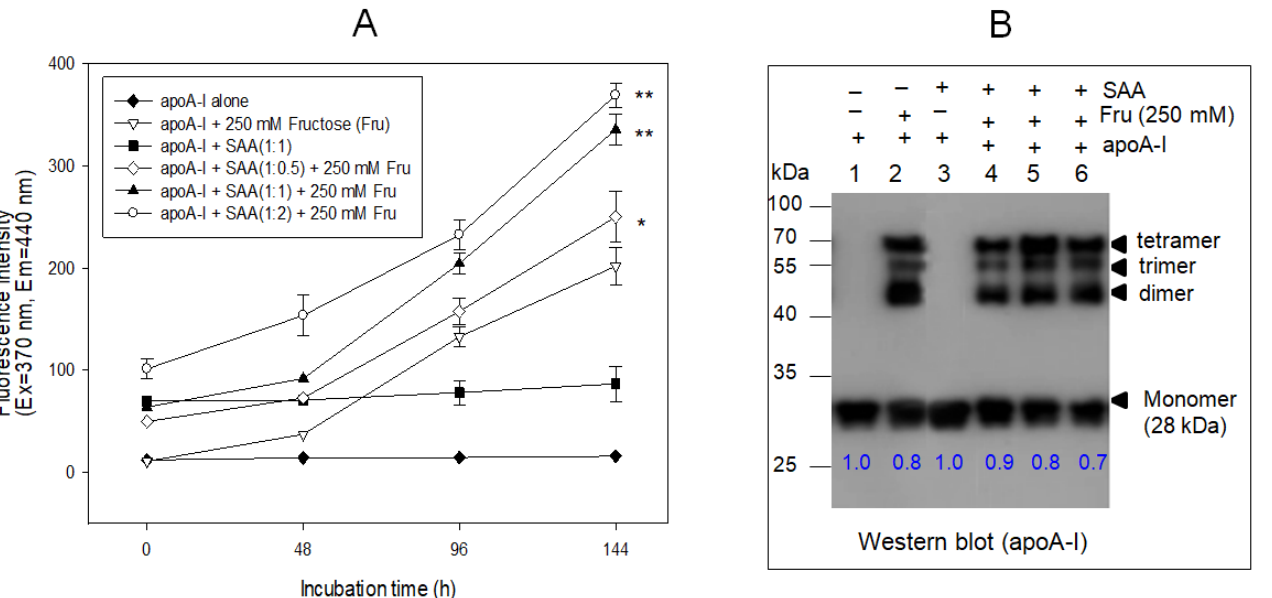
Figure 5. Isothermal denaturation of apoA-I and serum amyloid A (SAA) in the lipid-free state ( A ) and lipid-bound state ( B ) as reconstituted high-density lipoproteins (rHDL) with different molar ratios of apoA-I:SAA. With increasing urea treatment, change in Trp exposure was compared by fluorospectroscopy (Ex = 295 nm, Em = 310–400 nm) as wavelength maximum fluorescence (WMF).